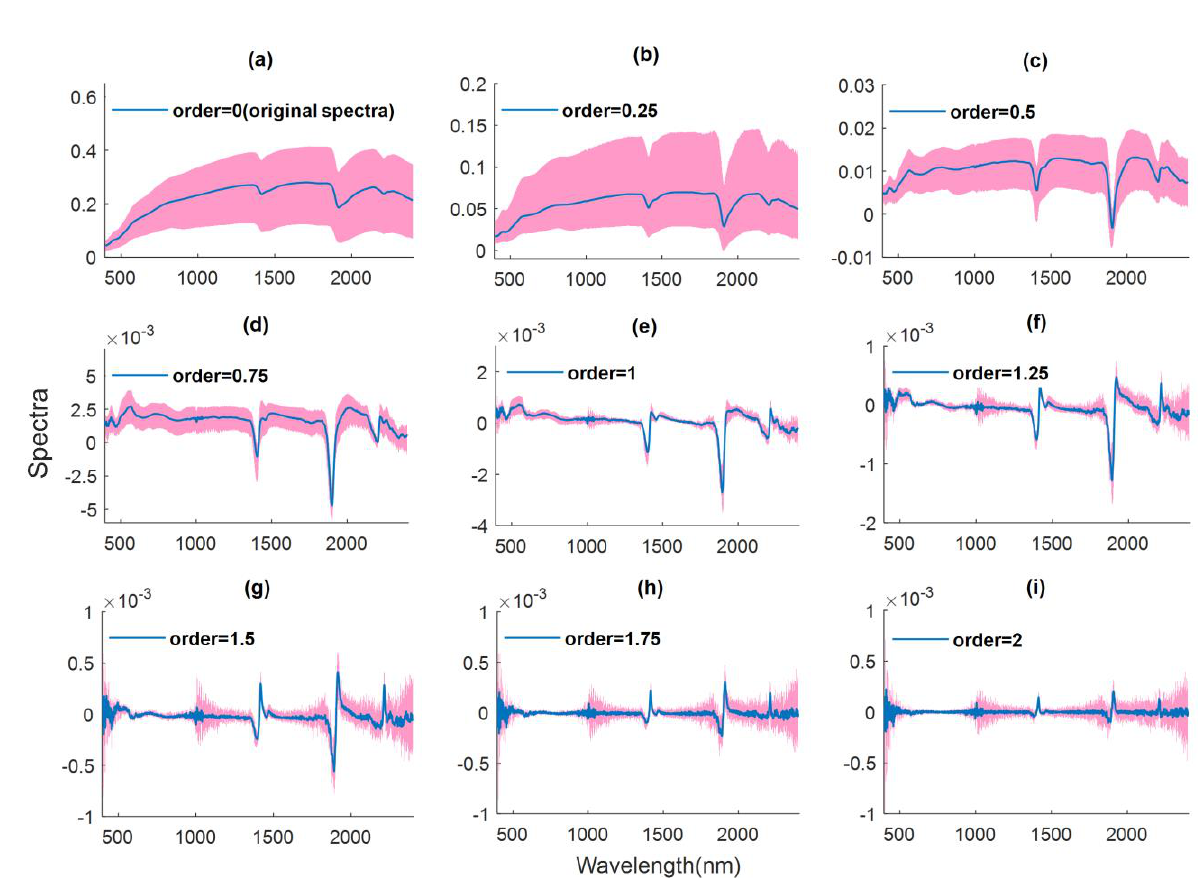
Figure 2. FOD spectra (0 to 2, increasement of 0.25 per step). Pink areas represent the whole scope of the spectra. Blue lines represent the mean